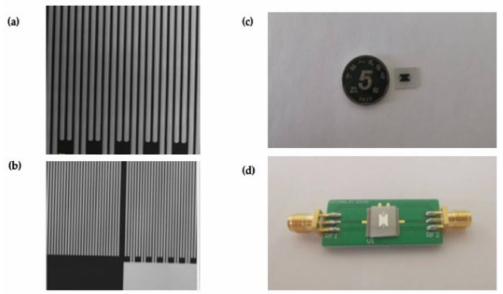
Figure 10. ( a ) The topography of double electrode transducers under confocal microscopy with 50-times magnification and ( b ) 20-times magnification. ( c ) Prepared SAW cryogenic temperature sensors, ( d ) SAW temperature sensors with PCB under test.